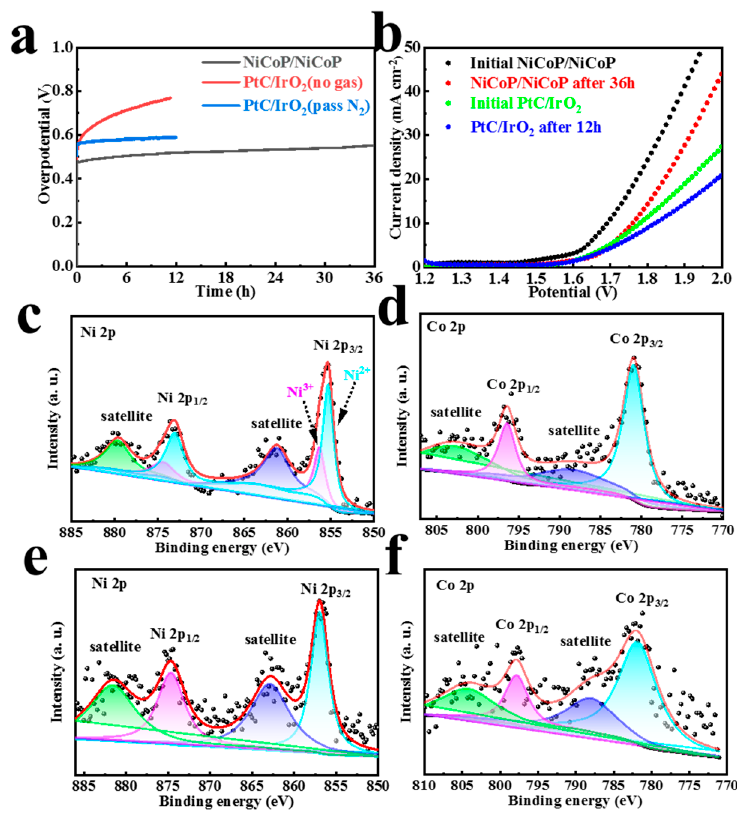
Figure 7. ( a ) Water splitting stability test of NiCoP/NiCoP and PtC/IrO 2 . ( b ) LSV curves of NiCoP/NiCoP and PtC/IrO 2 before and after overall water splitting. High-resolution XPS spectra of ( c ) Ni 2p and ( d ) Co 2p after HER in 1.0 M KOH. High-resolution XPS spectra of ( e ) Ni 2p and ( f ) Co 2p after OER in 1.0 M KOH.